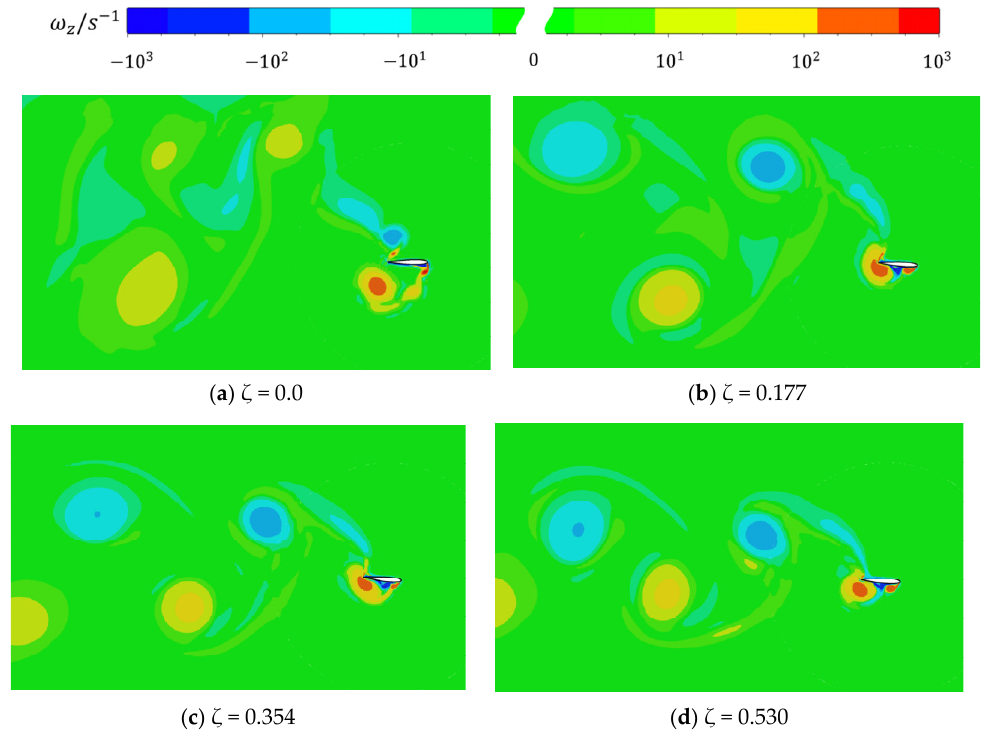
14 of 29 Figure 7. Variation of flapping-hydrofoil performance with different damping coefficients under baseline case. In Figure 7, the pitch amplitude of the foil keeps a large value under all damping coefficients, about 70~90°, which is very close to the experimental results (about 50~90°) and simulation results (about 70~90°) of Boudreau [25,26]. The large pitch amplitude will inevitably make the foil work at a large angle of attack. The wake vortex diagrams of the flapping hydrofoil with four damping coefficients under the baseline case are observed